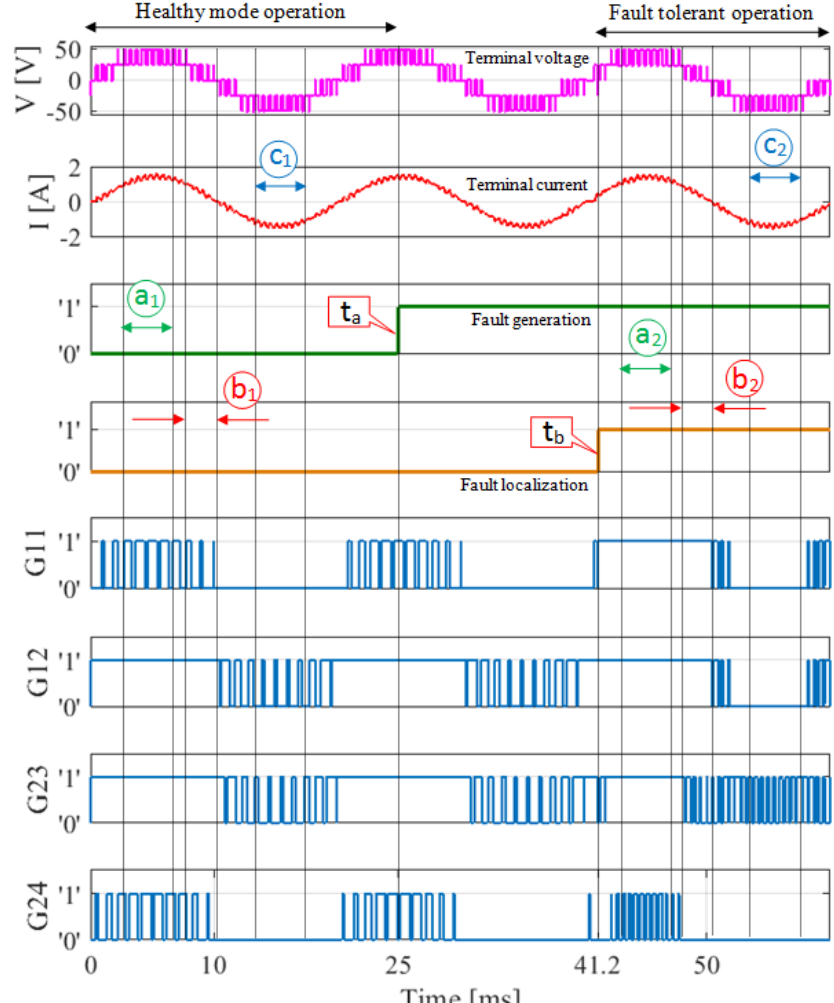
Figure 5. Simulation results for fault-tolerant operation of the inverter in the case of a short-circuit fault event in S12.